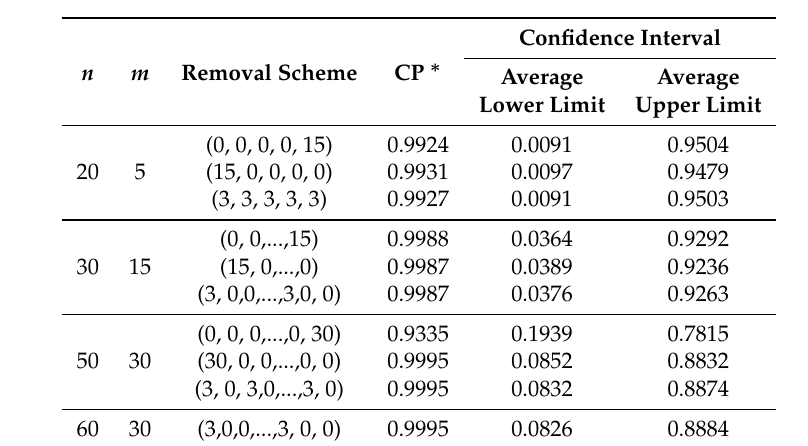
Table 1. The confidence interval of δ s , k (CI-D) of δ s , k and the coverage probability (CP) of the CI-D